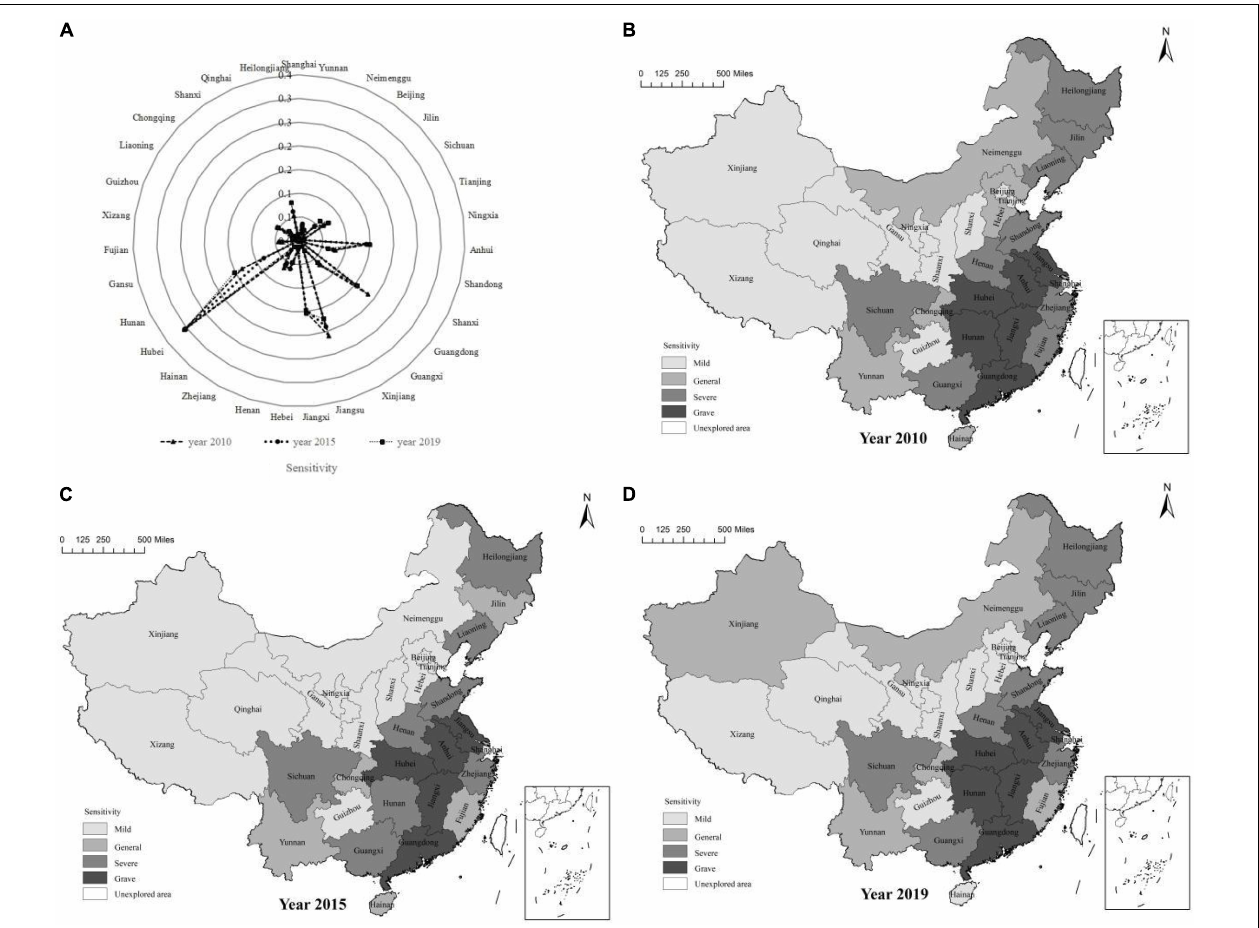
FIGURE 6 | Evaluation results and spatial distribution characteristics of flood disaster sensitivity of inland fisheries in China from 2010 to 2019. (A) Represents the radar diagram. (B) Represents the year 2010. (C) Represents the year 2015. (D) Represents the year